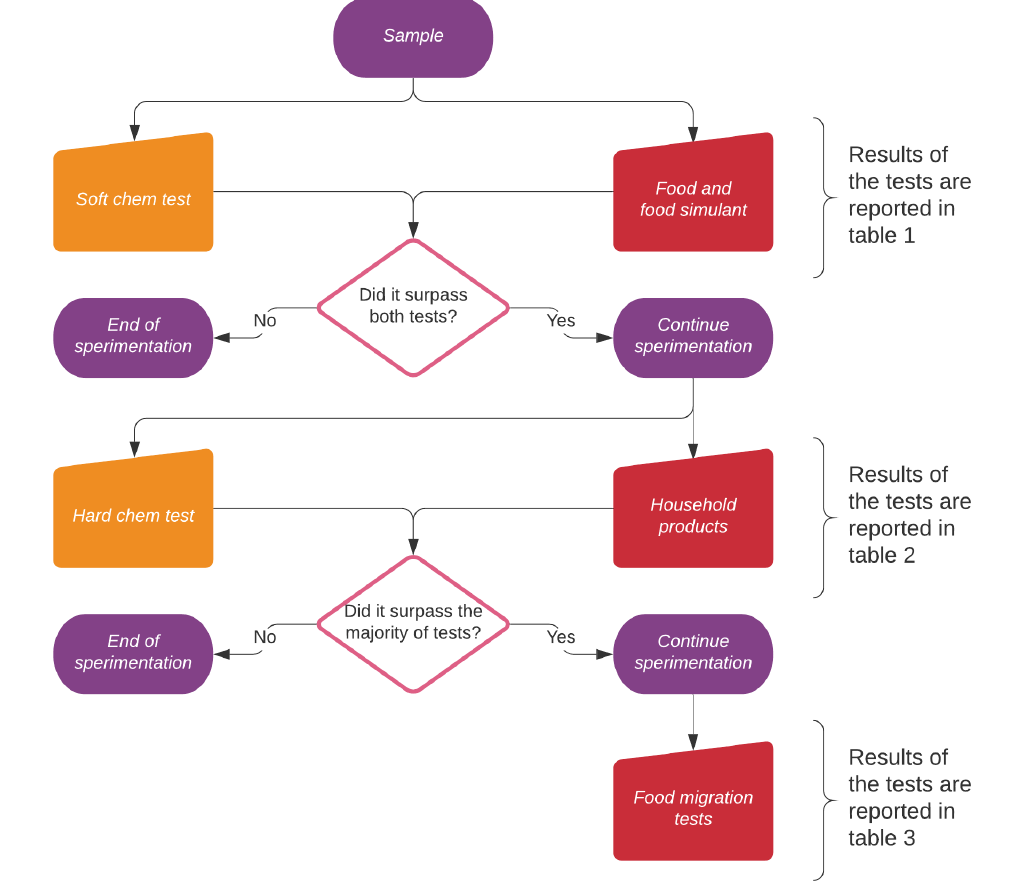
Figure 1. The samples were tested in three levels of increasing aggressivity. The first level is composed of two mild drop tests (one chemical and one with food and food simulants). The second level includes more aggressive agents, including harsh cleaning products. The last level concerns immersion migration tests on samples and on prototypes of coffee